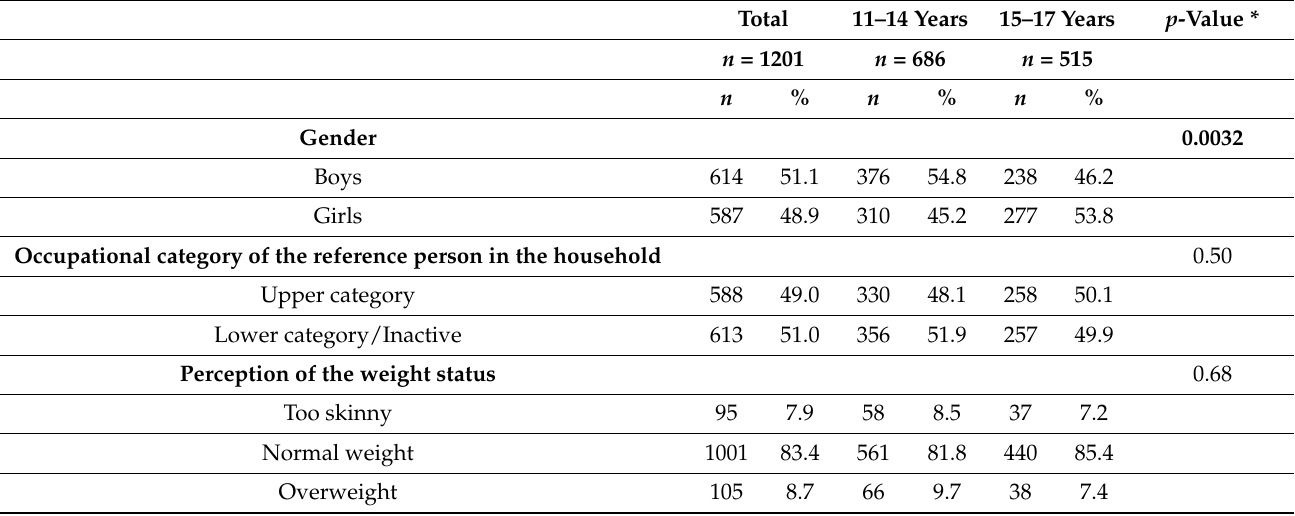
Table 1. Individual characteristics of the participants ( n = 1201-weighted data).